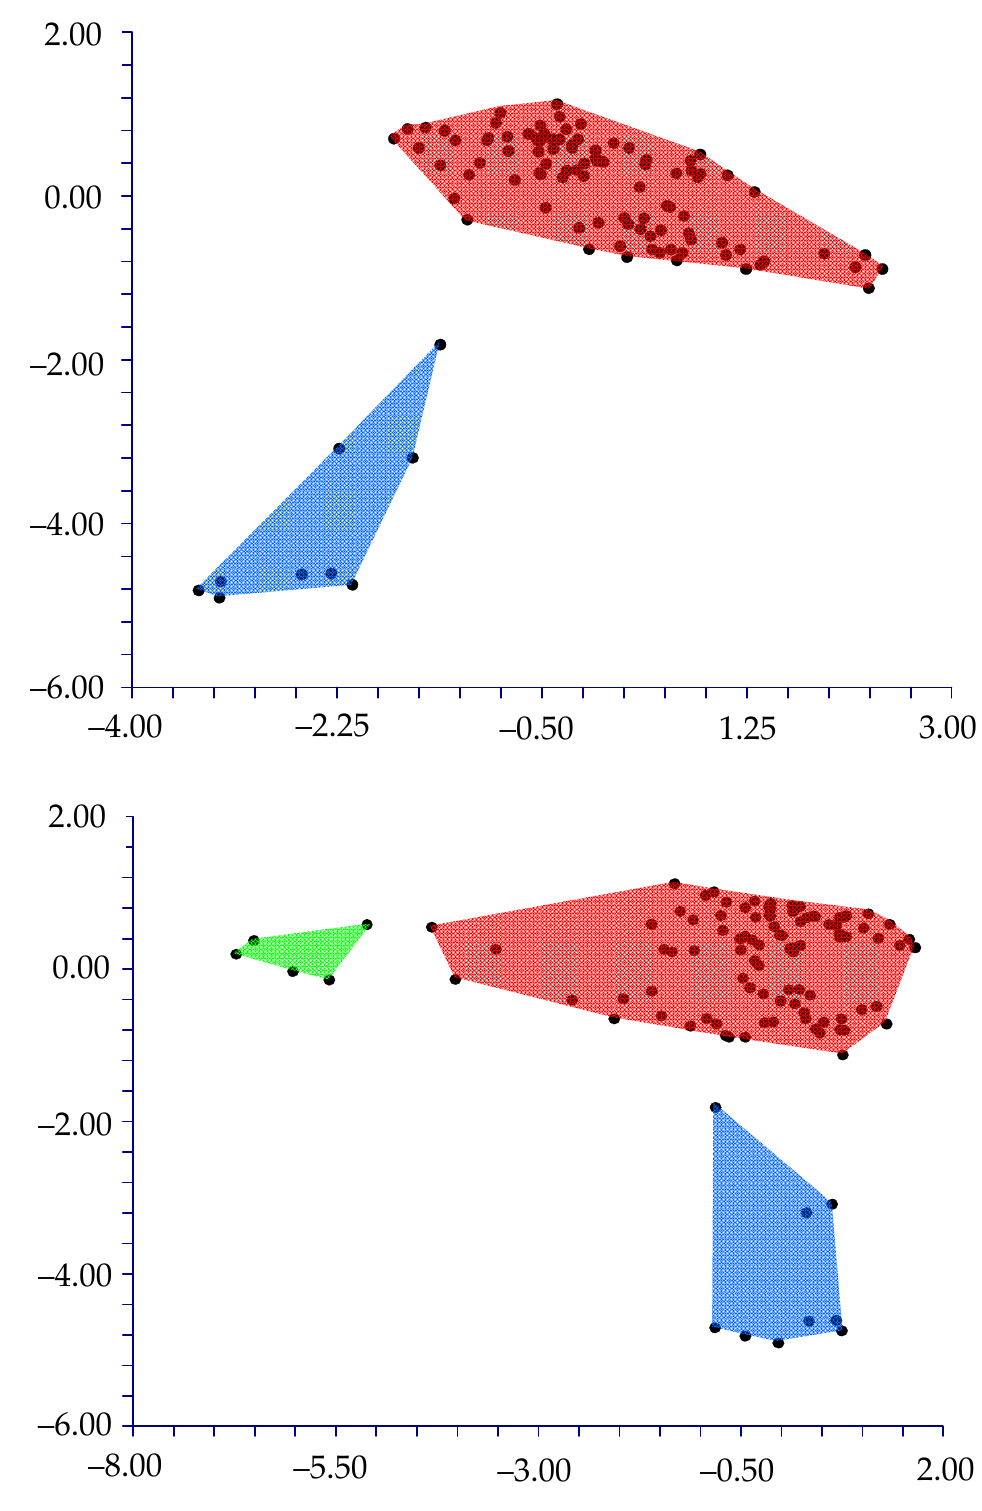
Figure 4. PCA graph: first ( x -axis) vs. second ( y -axis) components (graph on the top), and first ( x -axis) vs. sixth ( y -axis) components (graph on the bottom). Blue polygon: muricatus / viridis -group; green polygon: crassipes -group; red polygon: other samples/taxa.